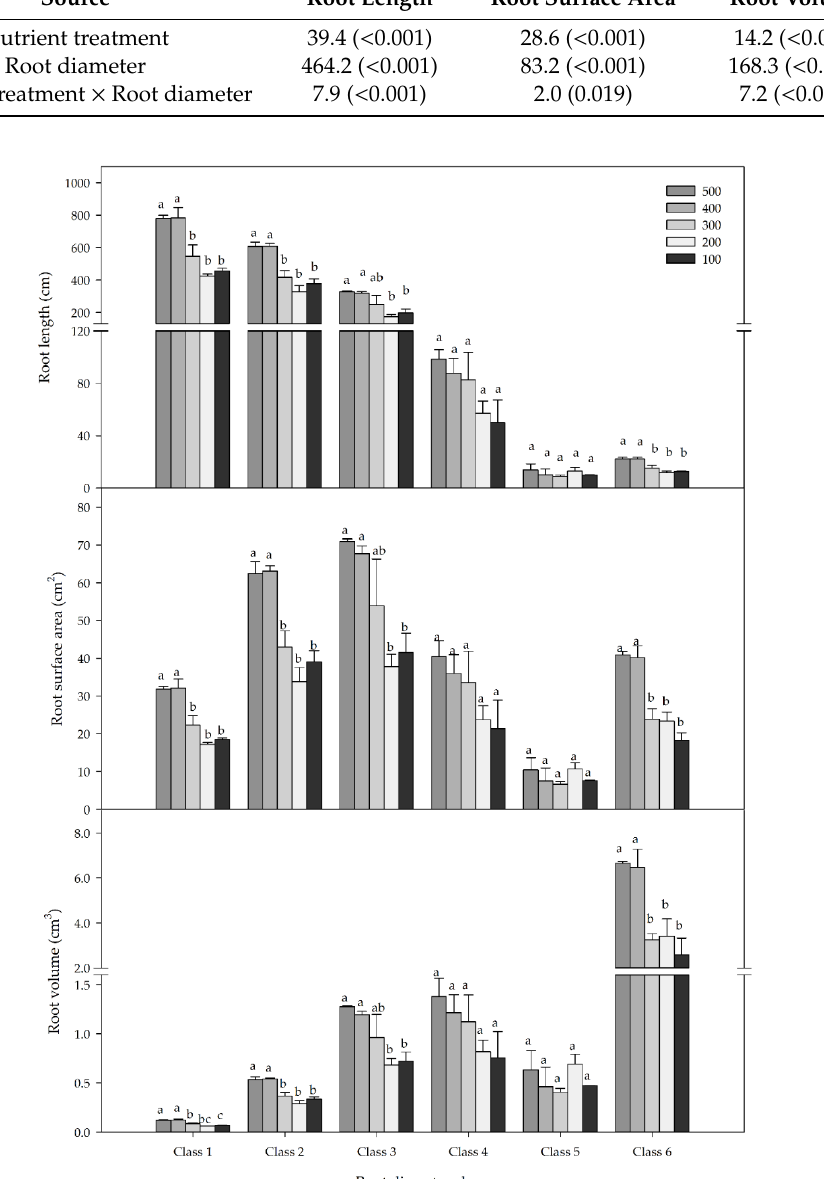
Figure 4. Root length, root surface area, and root volume of the P. chinensis seedlings among different root diameter classes under specific nutrient treatment conditions at the final harvest. The mean and SE are shown for each nutrient treatment and root diameter class. Nutrient treatments marked with different lowercase letters differ statistically at each root diameter class according to Duncan’s test at α = 0.05. Class 1, 0–0.2 mm; class 2, 0.2–0.5 mm; class 3, 0.5–1.0 mm; class 4, 1.0–2.0 mm; class 5, 2.0–3.0 mm; class 6 > 3.0